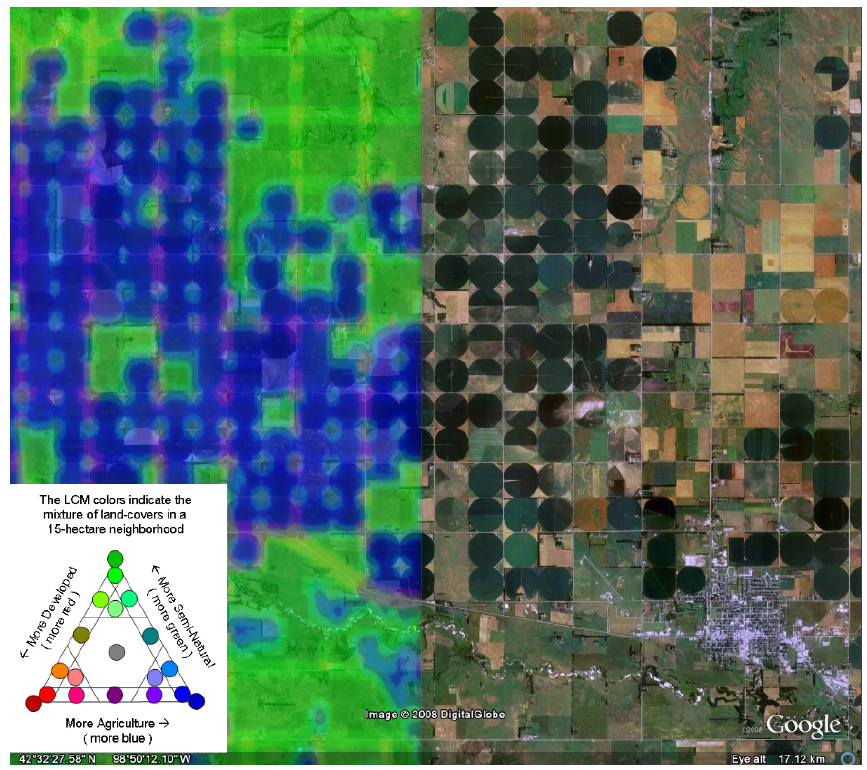
Figure 5: Illustration of viewing landscape mosaics with a geographic browser. The landscape mosaic map at left is partly transparent to reveal the underlying aerial photograph which continues without the landscape mosaic overlay at right. The circular features are irrigated croplands, embedded in a mostly-natural landscape mosaic in the Great Plains region of the United